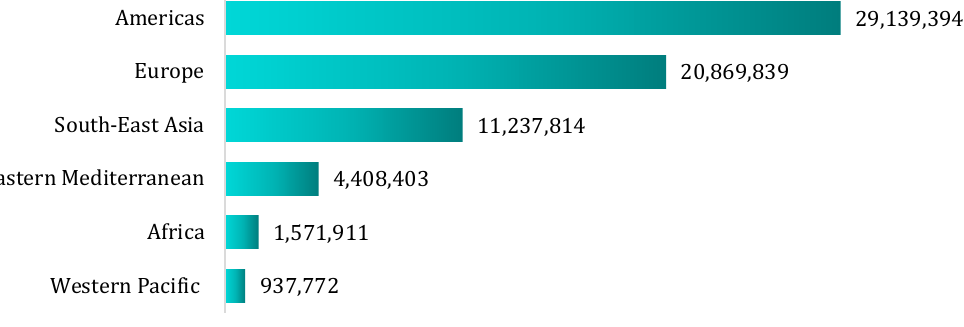
Figure 1. Number of confirmed cases according to WHO, as of 10.12.2020. Source: own study based on WHO (https://covid19.who.int) (WHO 2020).